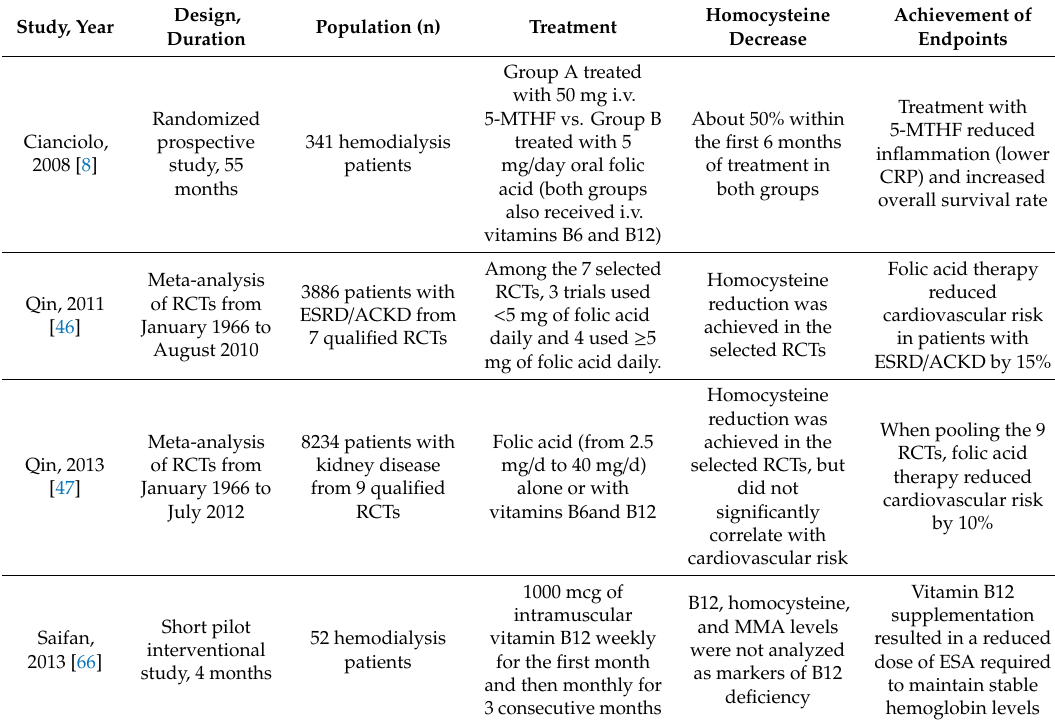
Table 2. E ff ects of treatment with B-vitamins on homocysteine lowering in patients with various stages of CKD. The two meta-analyses by Qin et al. [46,47] collect the most relevant studies published after 1966 about homocysteine-lowering therapy with folic acid in cardiovascular risk prevention in patients with kidney